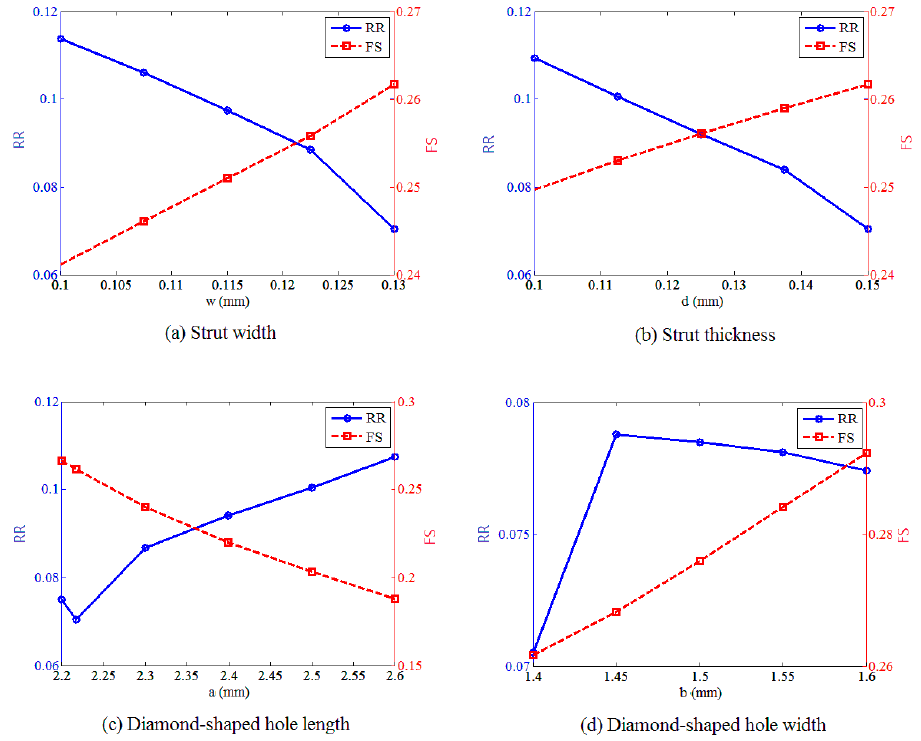
Figure 8. The effect of each design variable on the radial recoil and foreshortening when fixing other variables at their optimal values: ( a ) the effect of strut width on the radial recoil and foreshortening; ( b ) the effect of strut thickness on the radial recoil and foreshortening; ( c ) the effect of diamond-shaped hole length on the radial recoil and foreshortening; ( d ) the effect of diamond-shaped hole width on the radial recoil and foreshortening.